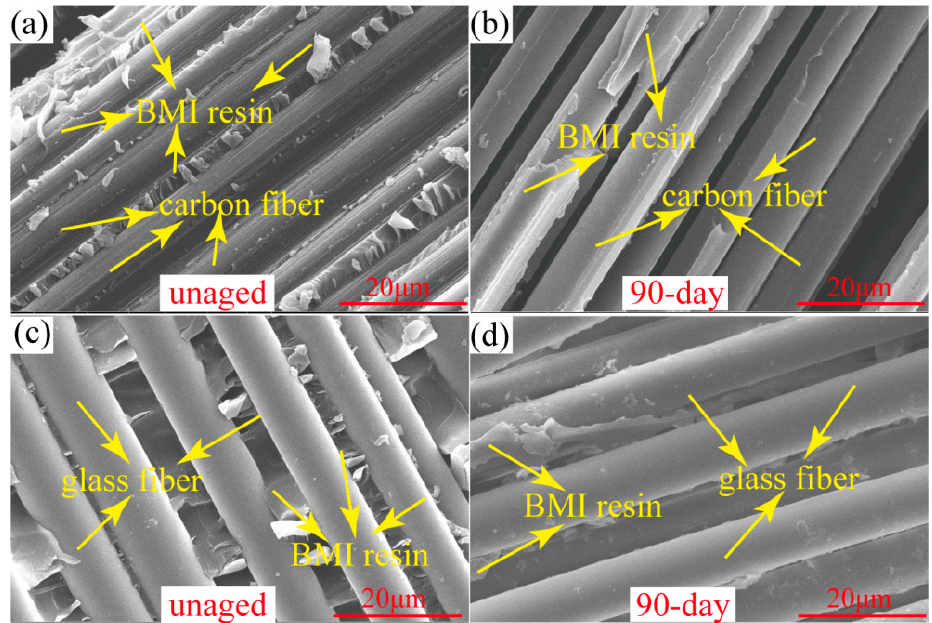
Figure 9. Scanning electron (SEM) pictures of fiber/matrix interface: ( a ) The unaged Com 2#, ( b ) the Com 2# at 250 °C aged for 90 days, ( c ) the unaged Com 3#, and ( d ) the Com 3# at 250 °C aged for 90 days.